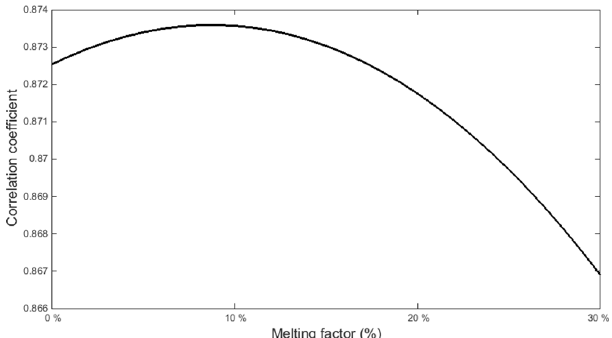
Figure 7. Correlation between the hourly TPB measurements and the DFAR measurements for different melting factors, where melt- ing factor is the percentage of the Thies tipping bucket precipitation from a given hour melted in the following